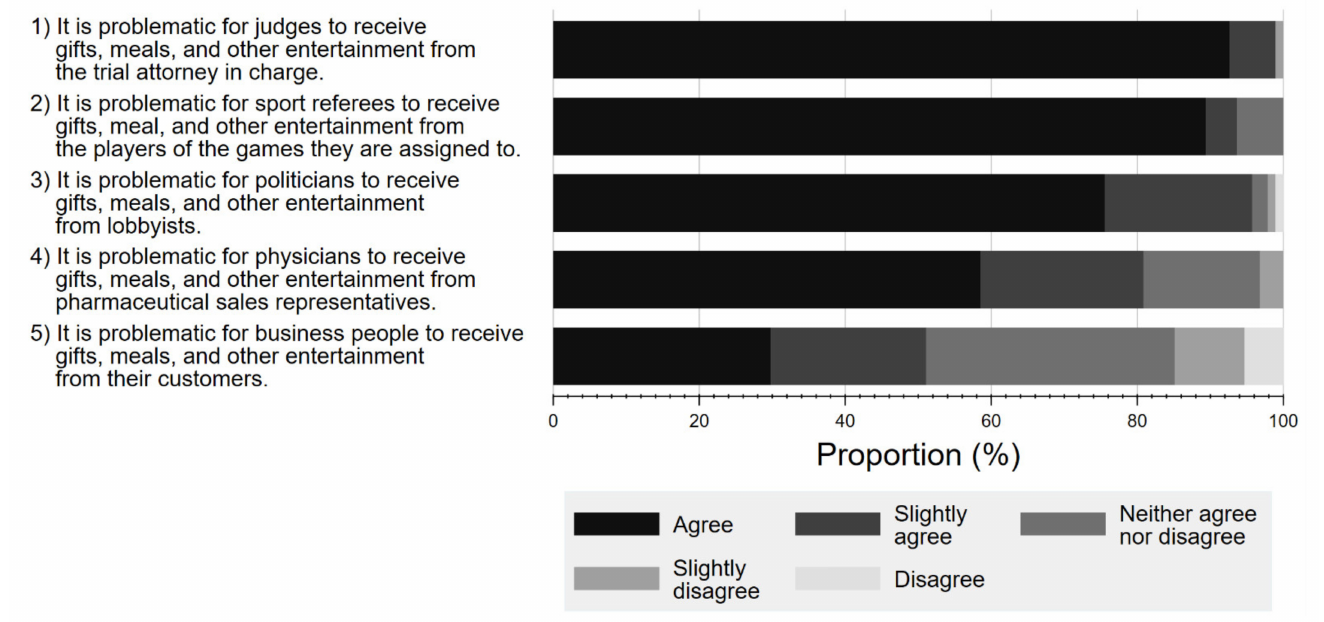
Figure 5. Respondent attitude about conflicts of interest among various